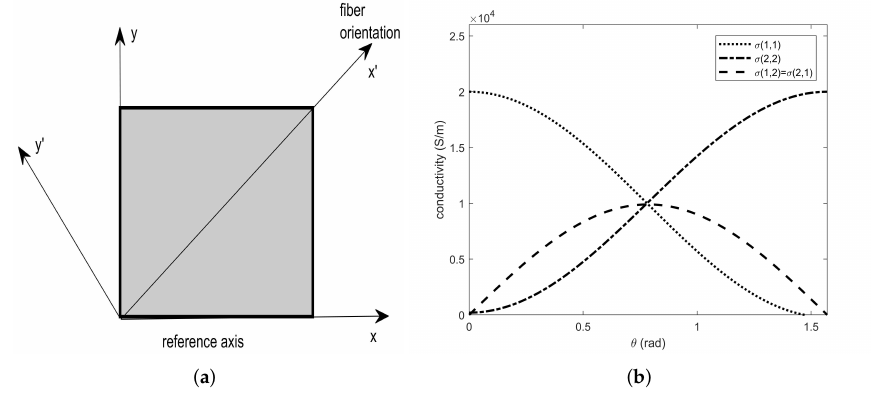
Figure 1. ( a ) Principal and reference axes. ( b ) The behavior of the conductivity matrix elements (6) as a function of the θ